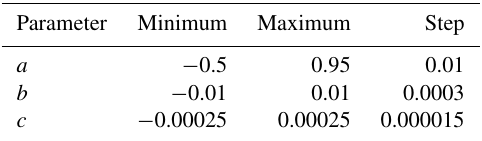
Table 2. In search for optimal g(R e ) , we list the range (minimum and maximum) and step size for each parameter in Eq.